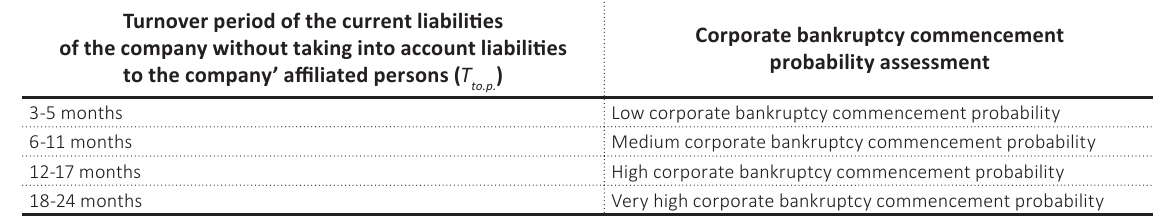
Table 1. Scale to assess the corporate bankruptcy commencement probability based on the calculated value of the turnover period of the company’s current liabilities without taking into account the liabilities to that company’ affiliated persons that require repayment Turnover period of the current